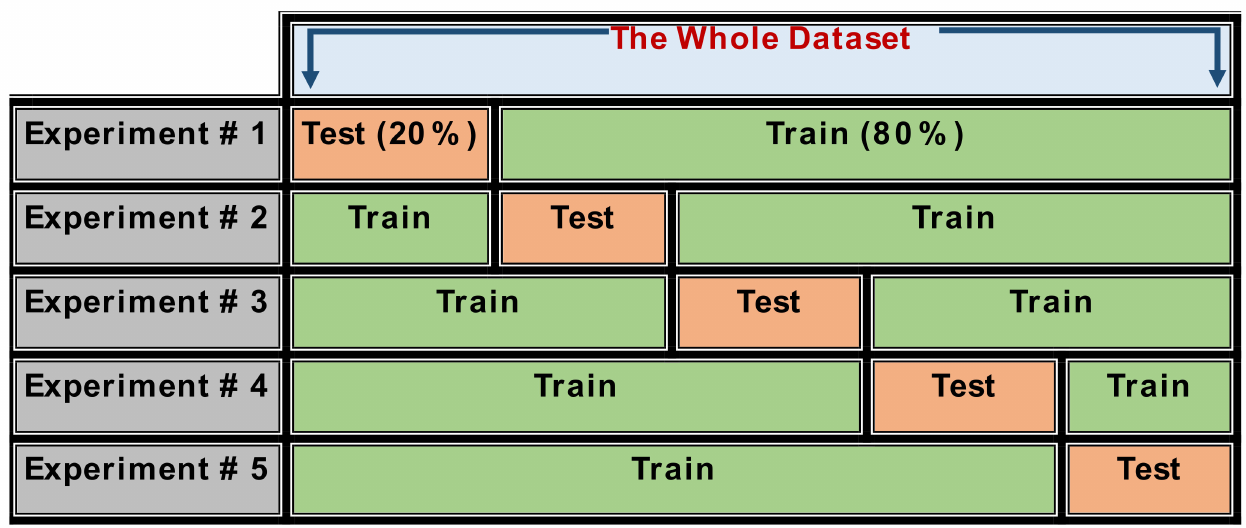
Figure 5. The 5-fold cross validation process used in this research.